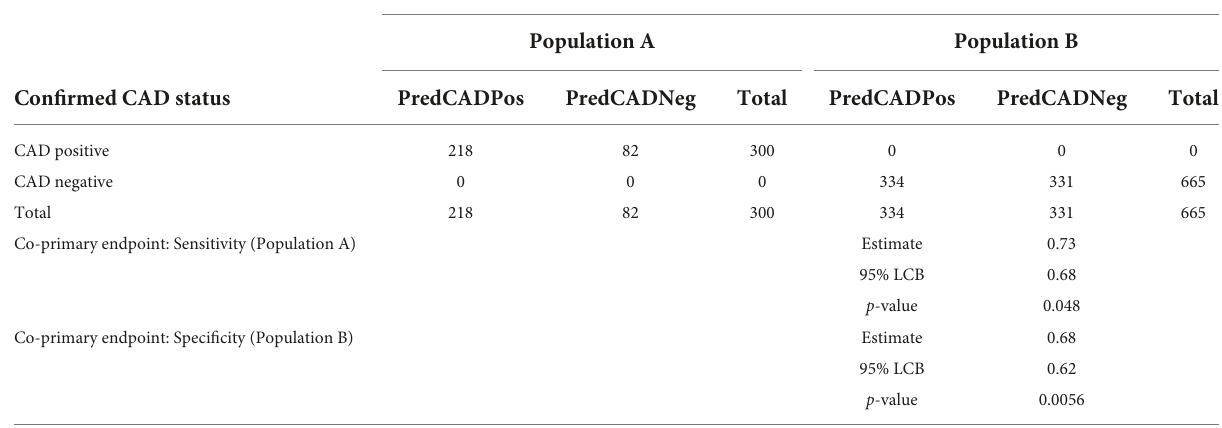
TABLE 5 Results of the machine learned algorithm when applied to the validation population.